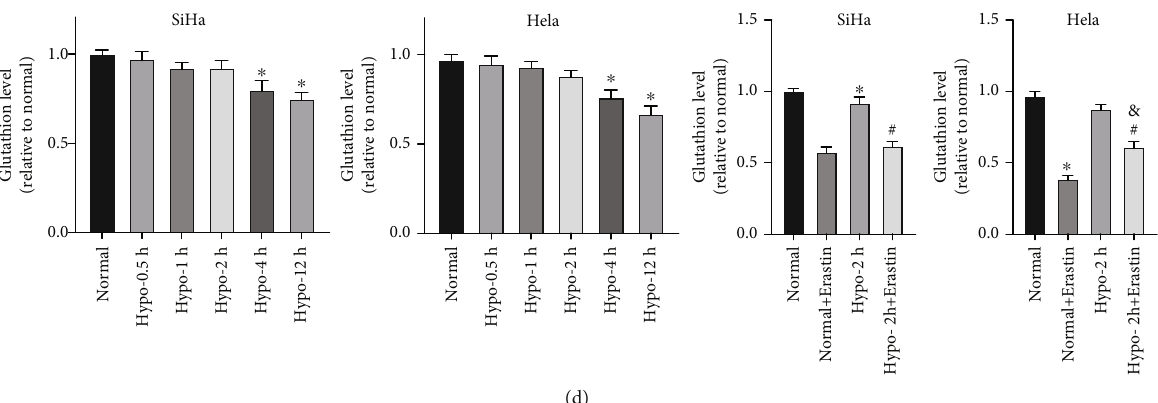
Figure 1: Hypoxia inhibited CC cell viability and induced ferroptosis resistance. SiHa and Hela cell lines were treated with hypoxia for 0.5, 1, 2, 4, and 12h, or SiHa and Hela cell lines cultured in normoxic and hypoxic conditions for 2 h were co-incubated with ferroptosis inducer Erastin for 24h. (A) Cell viability was determined by MTT assay; (B-D) The intracellular iron concentration, MDA, and GSH levels were measured using colorimetry method. The experiments were conducted in 3 replicates independently. The data were expressed as mean ± standard deviation. One-way ANOVA was adopted for comparisons among groups with Tukey ’ s multiple comparison test as the post hoc test; ∗ vs. the normal group, p < 0.05; # vs. the Hypo-2 h group, p < 0.05; & vs. the Normal + Erastin group, p <